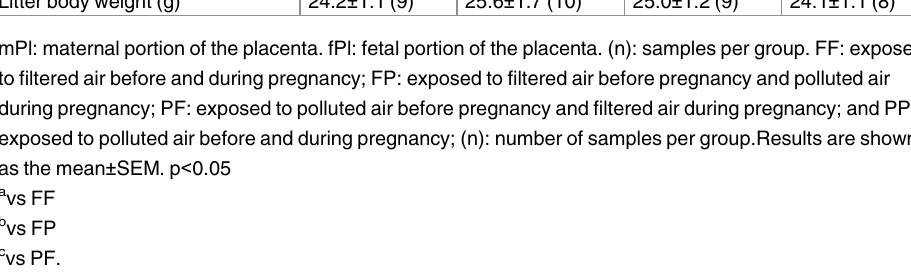
Table 7. Fetal parameters on the 19 th day of pregnancy. FF FP PF PP Litter size (number of